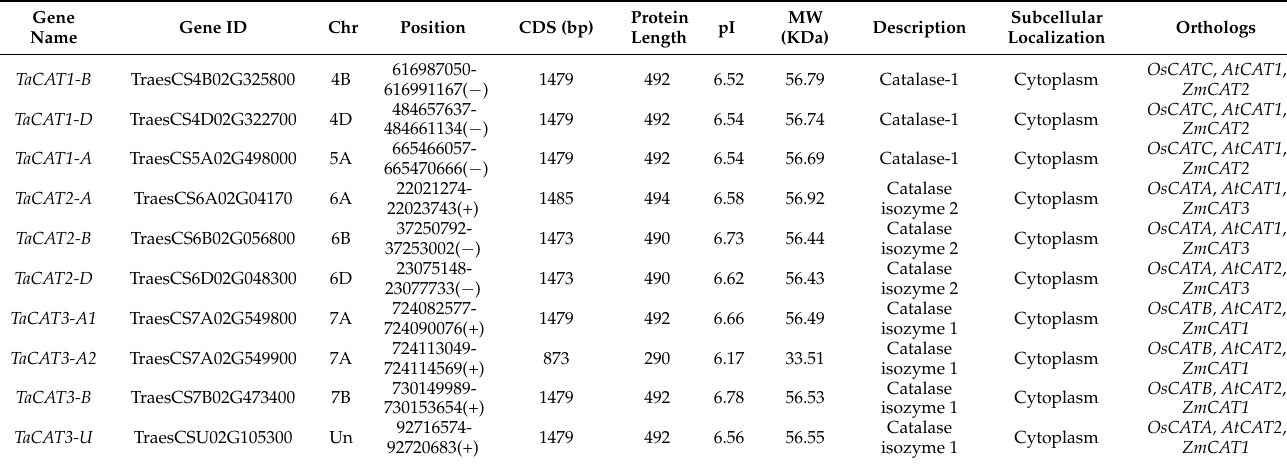
Table 1. Detailed information of identified TaCAT